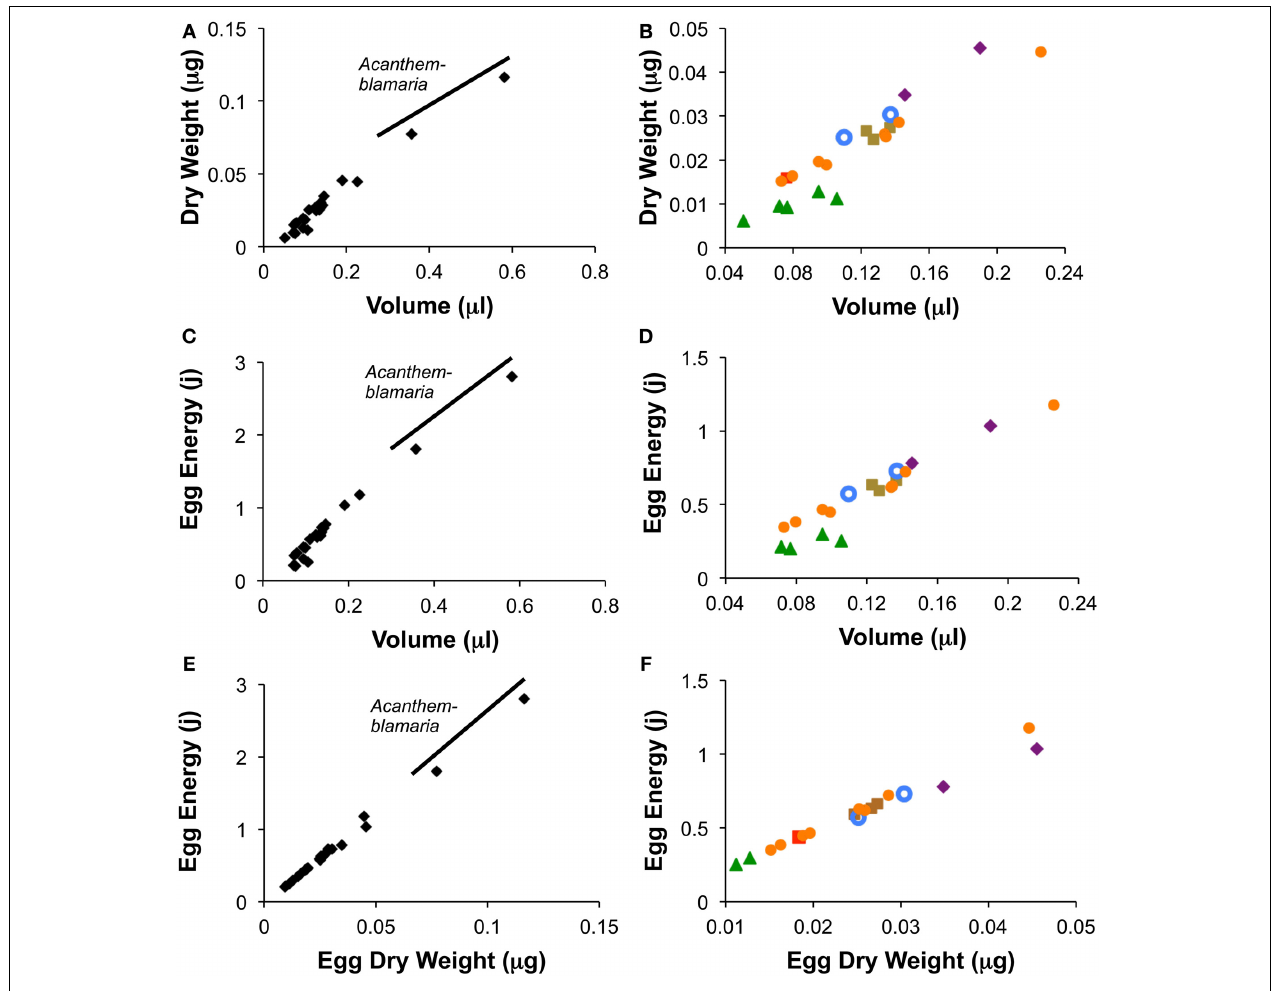
FIGURE 4 | Relationships between egg volume and egg dry weight (A,B), volume and egg energy content (C,D) and egg dry weight and egg energy content (E,F) for the 24 species of neotropical fishes. Figures show species means for wet season data only. Graphs on the left (A,C,E)